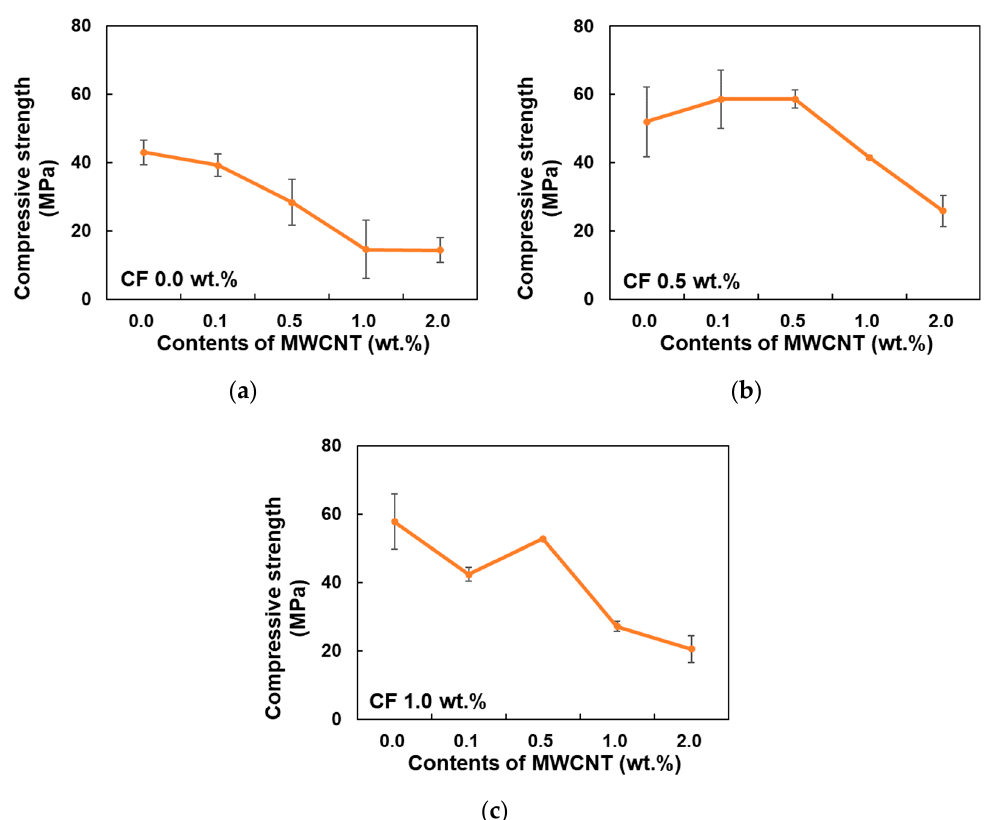
Figure 4. Compressive strength results of CF filler-incorporated AAS composites with ( a ) 0 wt.%, ( b ) 0.5 wt.%, and ( c ) 1.0 wt.% of CF.